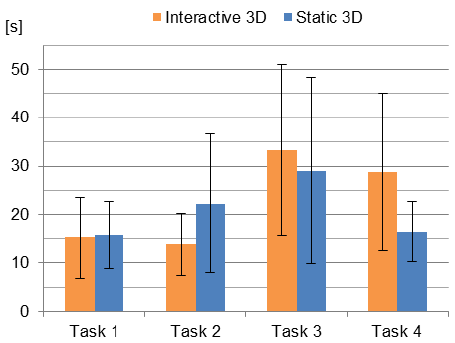
Fig. 6. Average speeds (lengths) and standard deviations of task performance